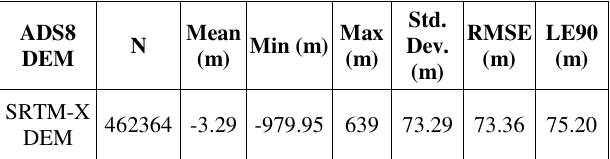
Accuracy is normally presented using RMSE (Root Mean Square Error) value but more robust measure of DEM accuracy is linear error at 90% confidence interval. In the present study, SRTM X band DEM shows RMSE of 73.36m with respect to ADS80 DEM which is quite high from the clamed ones. The calculated LE 90 is 75.20 m. It can be observed from the above comparison of SRTM X band DEM with ADS80 reference DEM that the accuracy achieved for part of Himalayan region is far less as compared to the values officially claimed. Thus, SRTM X band DEM should be used with due care in mountainous regions of